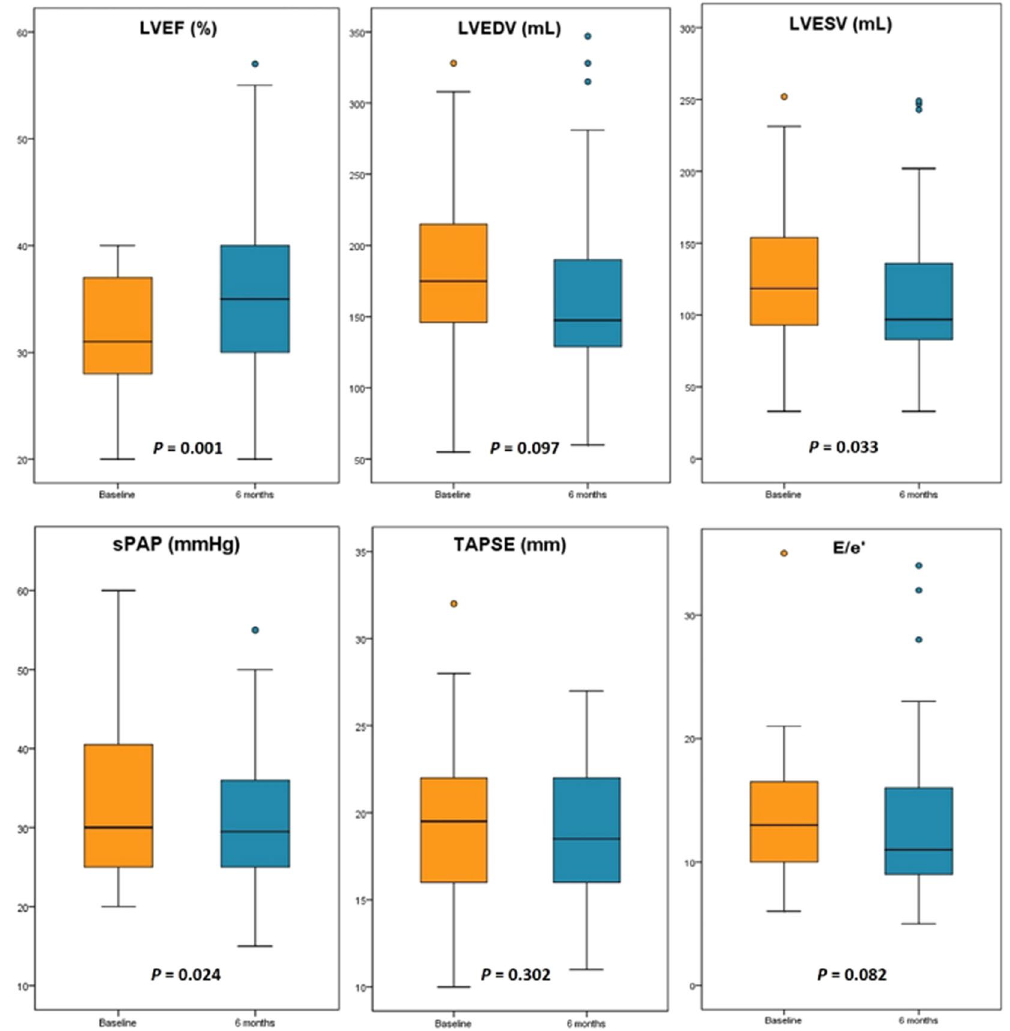
Figure 4. Box plots showing the changes of echocardiographic parameters form baseline to 6-months follow-up in patients treated with Sacubitril/Valsartan. The boxes represent the interquartile range of the samples and include the median value (horizontal line). The line across the boxes reache the maximum and minimum values. LVEF, left ventricular ejection fraction; LVEDV, left ventricular end diastolic volume; LVESV, left ventricular end systolic volume; sPAP, systolic pulmonary artery pressure; TAPSE, tricuspid annular plane systolic